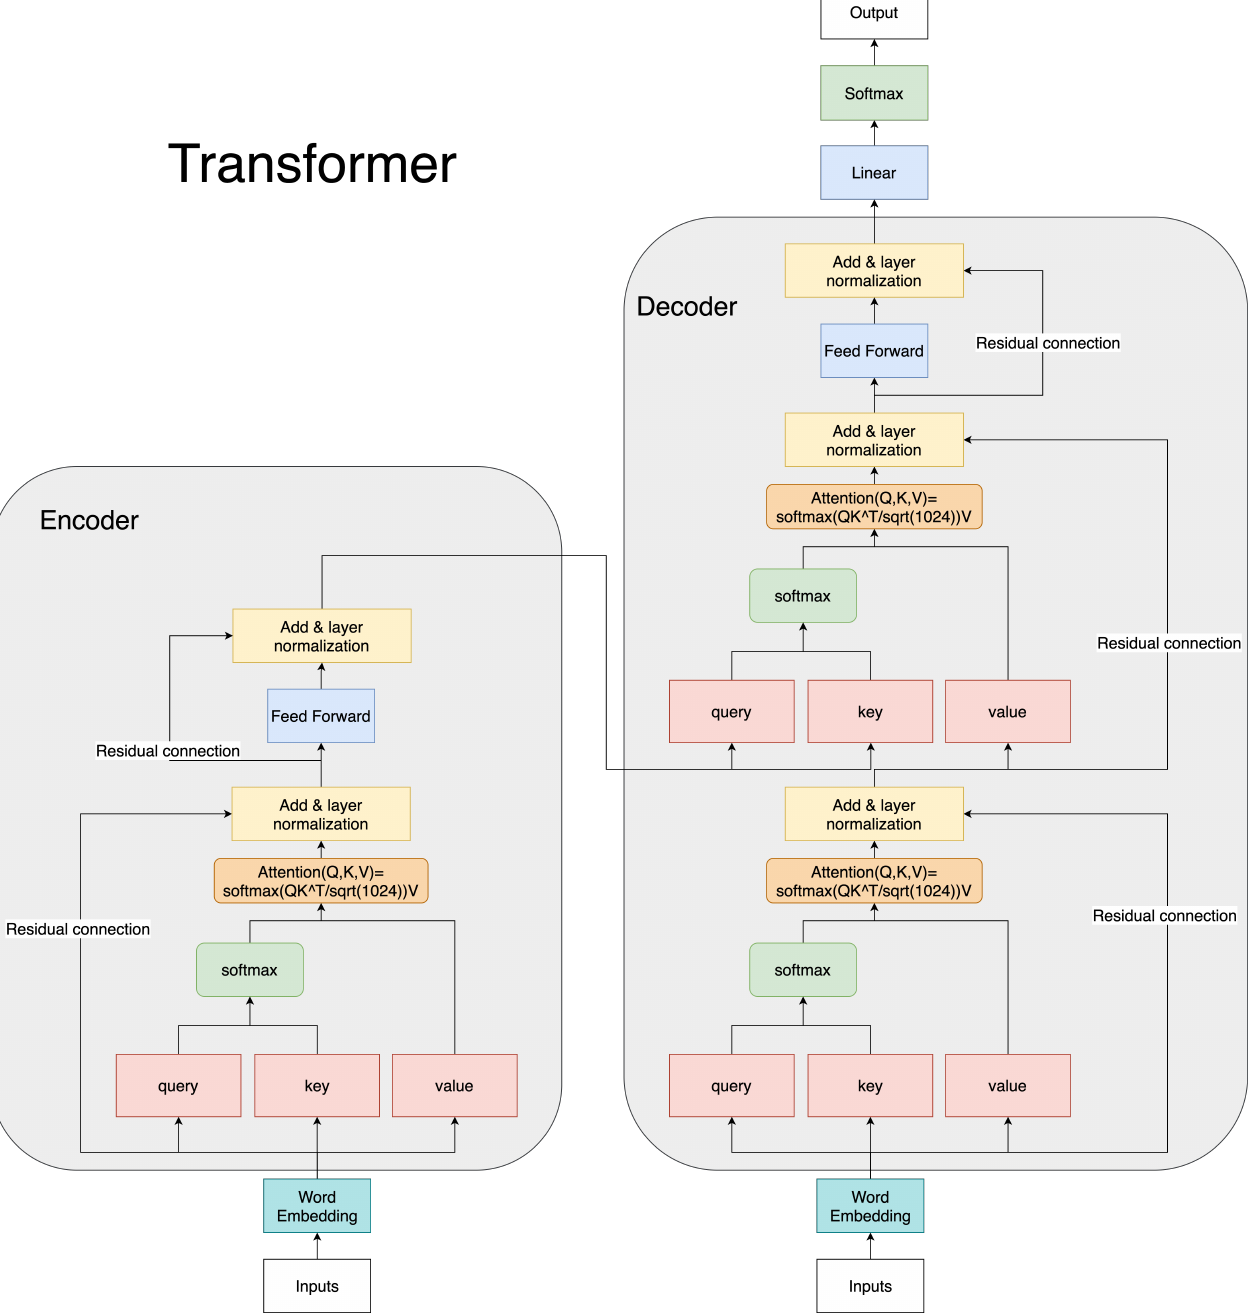
Figure 2. This is a diagram of the encoder–decoder of a transformer. The structure is the basis for BERT and GPT-2, which are used in this